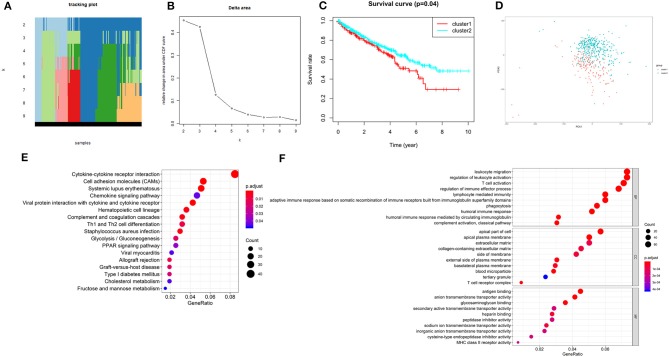
Overall survival of ccRCC patients in cluster 1 and 2 subgroups. (A) The tracking plot for k = 2 to k = 9. (B) Relative change in area under CDF curve for k = 2–9. (C) Kaplan-Meier overall survival (OS) curve for ccRCC patients in cluster 1 and 2. (D) Principal component analysis of the total RNA expression profile. ccRCC in cluster1 are marked in red. (E,F) Functional annotation of the genes with different expression in the cluster 1 using KEGG pathway (E) and GO terms (F).